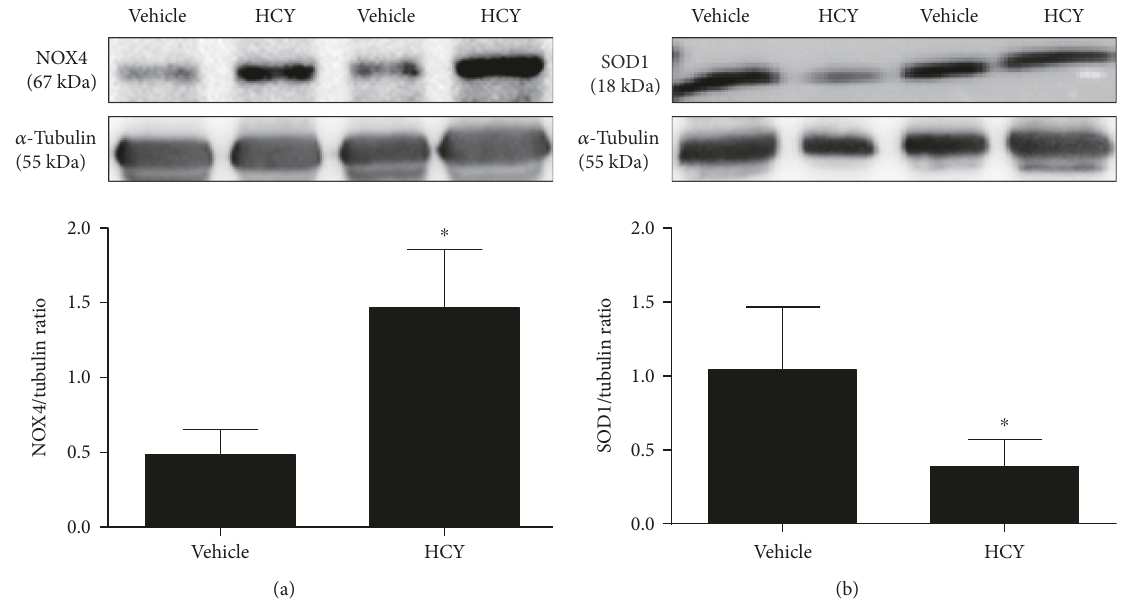
Figure 4: Protein levels of NOX4 and SOD1 in the RVLM in response to systemic HCY. As shown, NOX4 was dramatically increased within the HCY group (a) while SOD1 represented the opposite (b). n = 4 ‐ 5 /group. ∗ P < 0 05 versus the vehicle